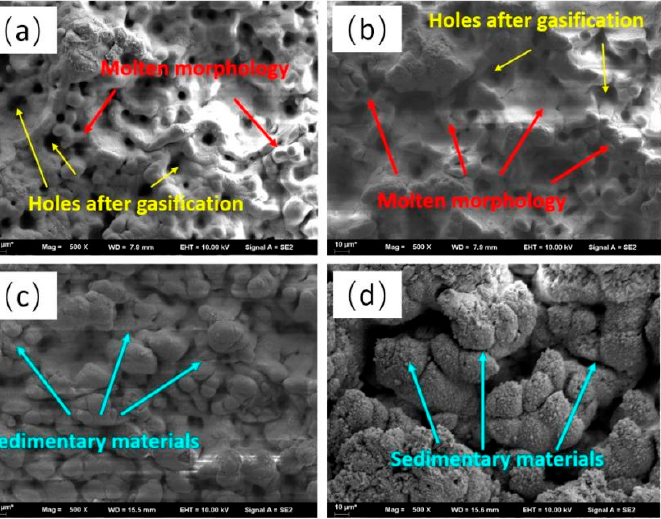
Figure 3. Surface microstructure after laser milling at different laser powers: ( a ) 25 W; ( b ) 30 W; ( c ) 35 W; ( d ) 40 W. ( c ) 35 W; ( d ) 40